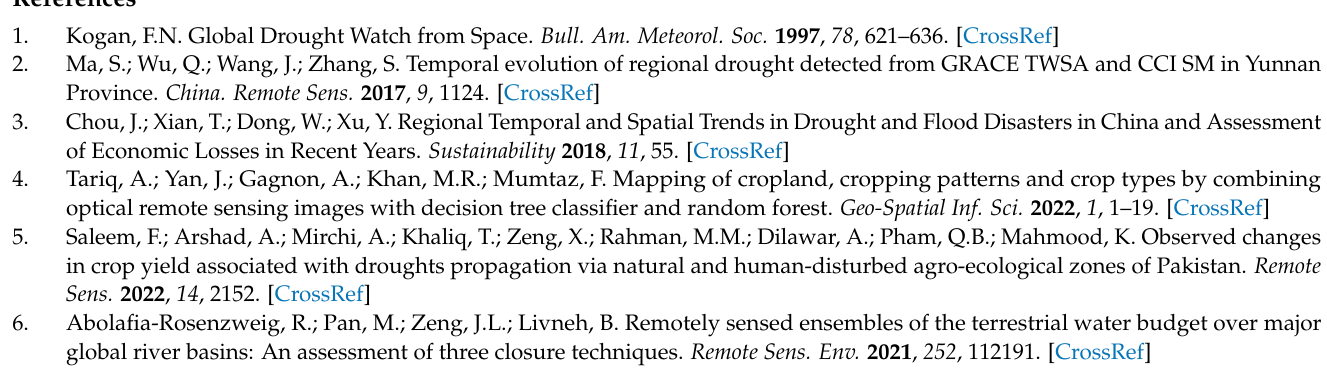
Figure S3: (a) Comparison between WSDI and inter-annual trend, and (b–f) comparison between STL decomposed inter-annual trends and original data of climatic variables; Figure S4: Comparison of trends between WSDI and climate variables (a) WSDI and precipitation and (b) WSDI and potential evaporation; Figure S5: Comparison of eight drought events identified by total WSD and WSDI during the study. The most severe droughts in 2010 and 2016 are shown with red shading